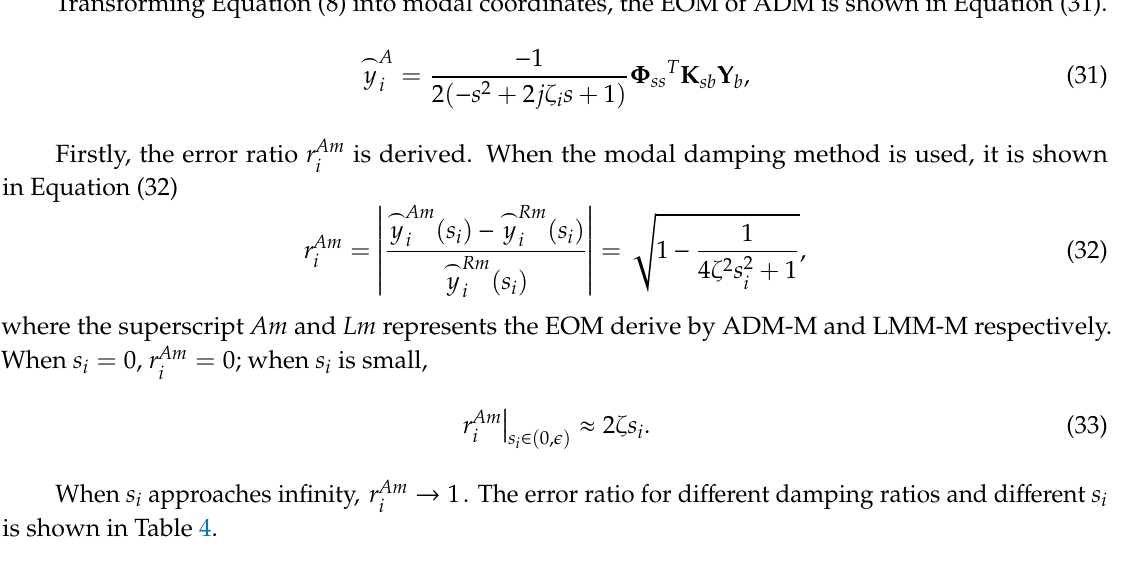
Figure 3. Examples of Rr r for a particular parameter setting.